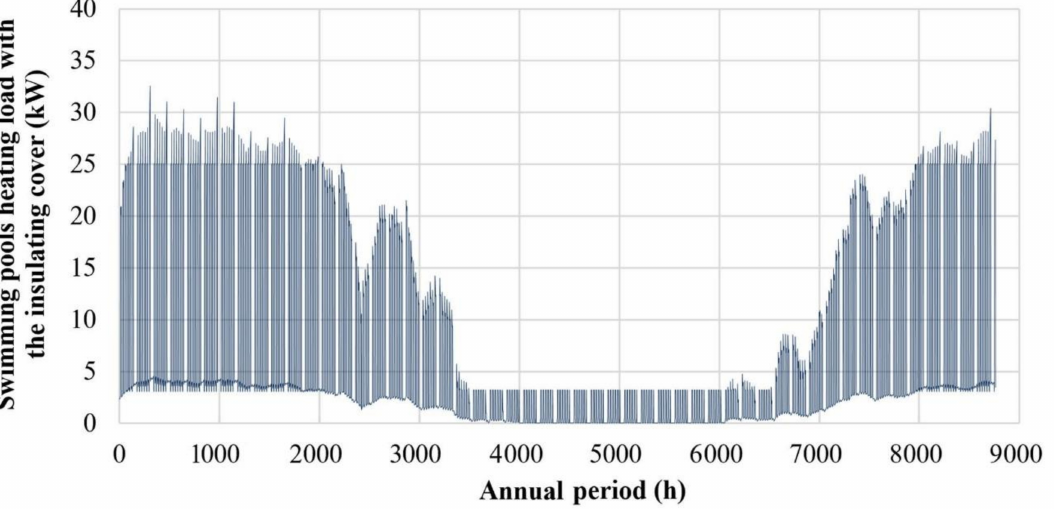
Figure 17. Annual thermal power required for the swimming pools’ heating with the introduction of the insulating